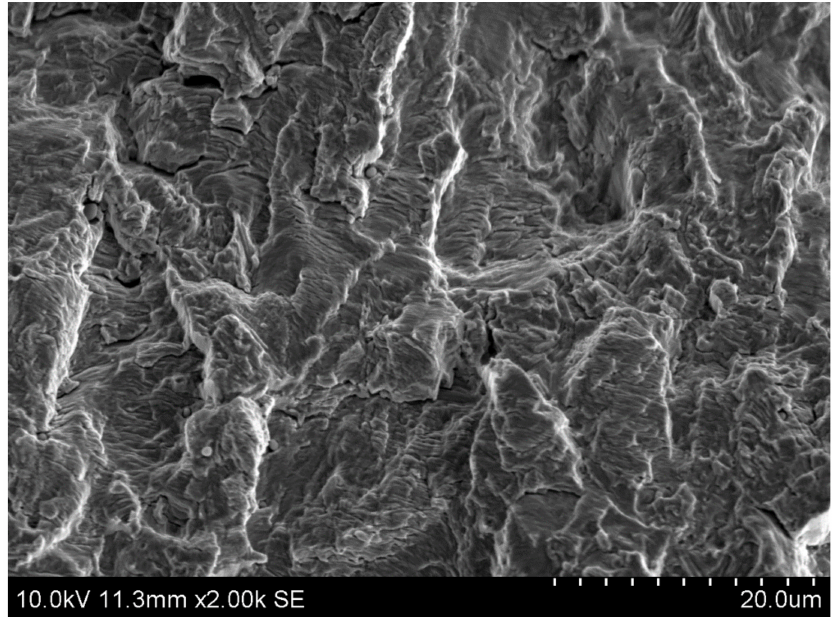
Figure 13. Initial fatigue crack path (24.5 mm) of the tested specimen with stop hole ( ∆ K = 40.4 MPa × m 0.5 ), crack growth direction from bottom to top, fracture surface located close to the drilled hole with reinitiated fatigue crack—noticeable fatigue